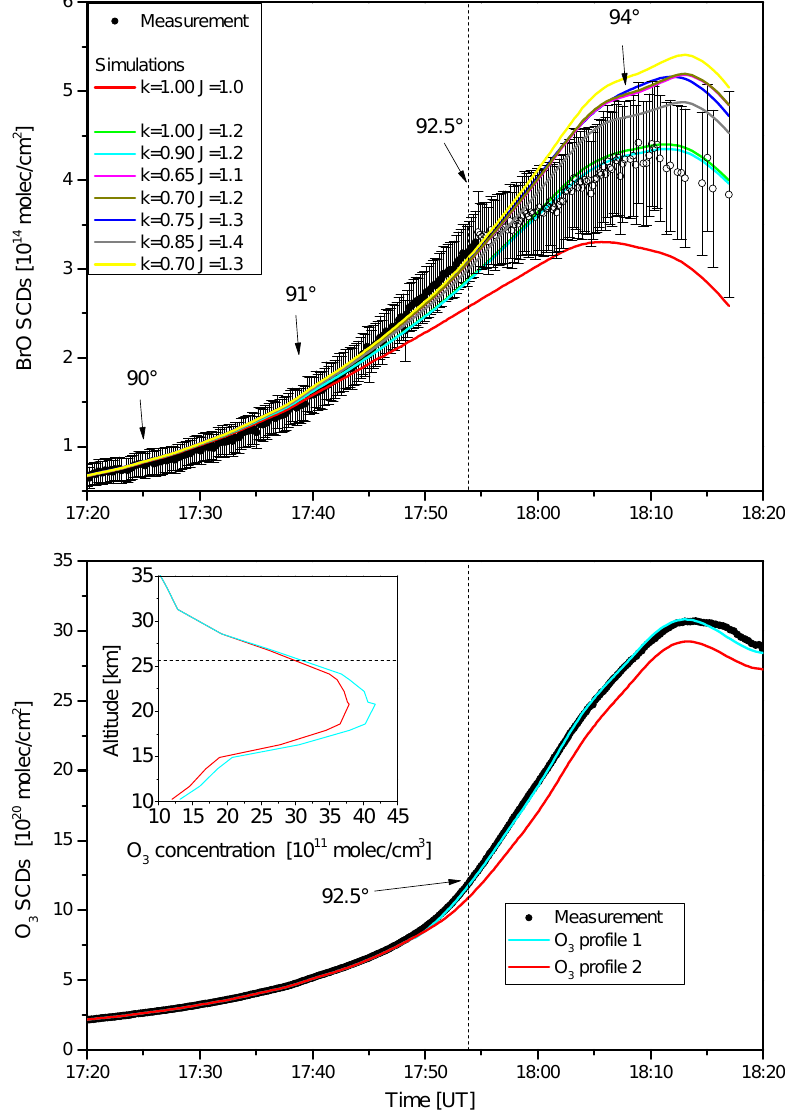
Fig. 5. Inter-comparison of measured versus modelled slant column densities of BrO (upper panel) and O 3 (lower panel) for the sunset solar occultation measurements on 7 September 2009. The data points shown with filled black dots are included, while the data points with open dots are disregarded in the analysis. The coloured lines in the upper panel show simulations for different pairs of J ( BrONO 2 ) and k BrO + NO as indicated by the legend. Local solar zenith angles (e.g. 90 ◦ , 91 ◦ , 92.5 ◦ , and 94 ◦ ) of some measurements are also indicated. The lower panel shows the measured O 3 SCDs in solar occultation, and the lines in red and light blue show the modelled O 3 SCDs for the two ozone profiles shown in the inset, respectively. The ozone profile (red line) is inferred from direct sunlight measurements in the visible spectral range during the balloon ascent (i.e. close to balloon sounding) and the ozone profile in light blue is a tuned profile to fit best the O 3 SCDs for SZA > 92 . 5 ◦